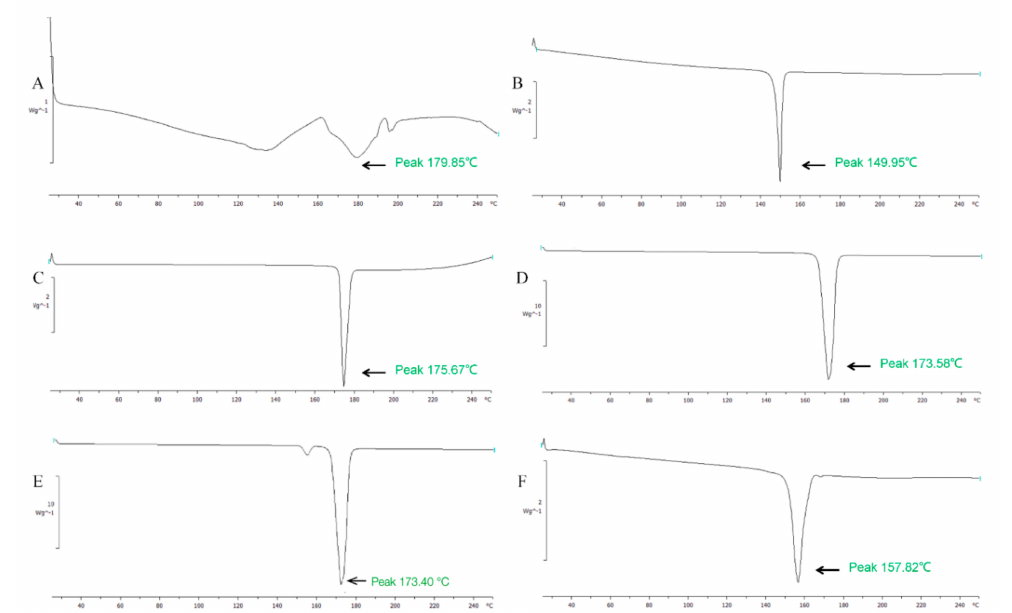
Figure 3. The DSC analysis of nifedipine formulations. ( A ) phospholipid, ( B ) cholesterol, ( C ) nifedipine, ( D ) mannitol, ( E ) physical mixture, and ( F ) nifedipine